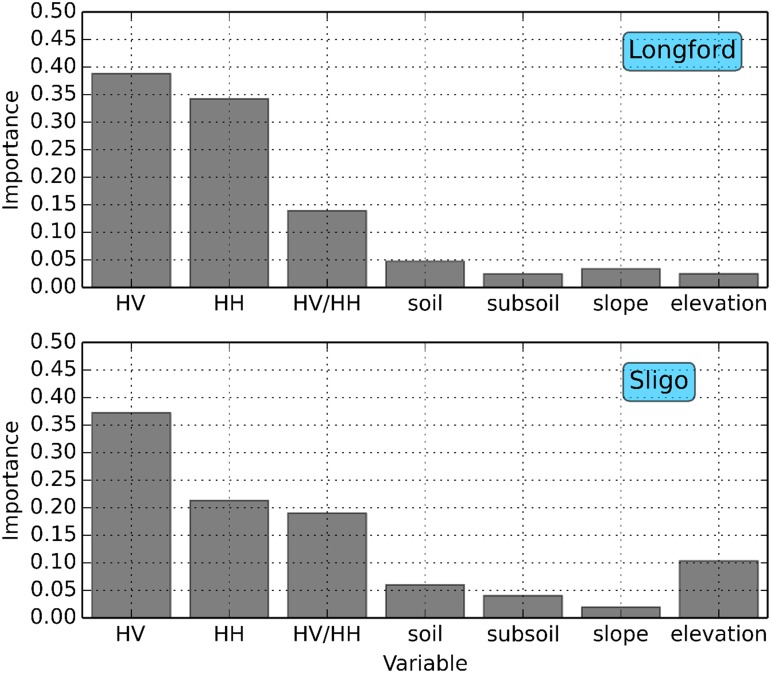
Variable importance scores of the radar backscatter intensities and ancillary data for Longford (top) and Sligo (bottom).